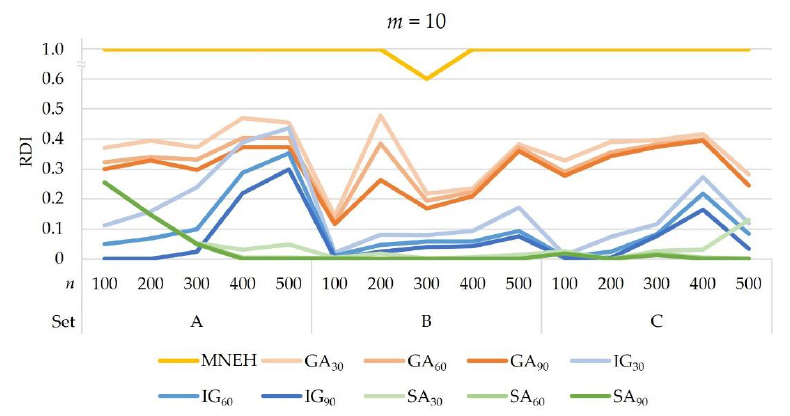
Figure 12. RDIs of the heuristic algorithms on large instances.